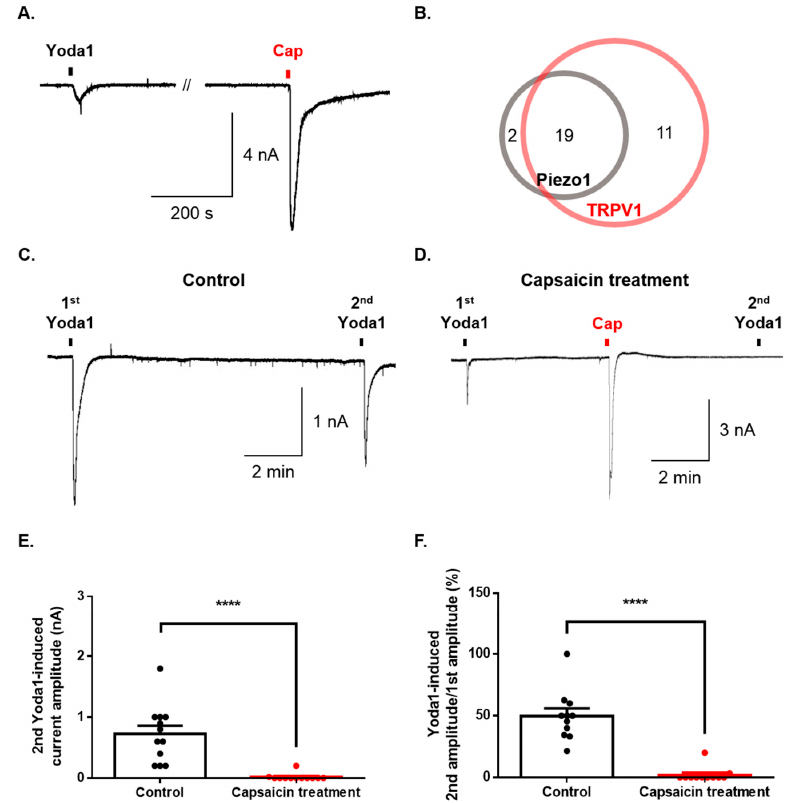
Figure 4. Regulation of Piezo1 by TRPV1 activation in the same dorsal root ganglion (DRG) neurons. ( A ) Representative trace of the inward current induced by Yoda1 (10 µ M, 10 s) and capsaicin (cap, 100 nM, 10 s) in the same neuron. ( B ) The number of neurons activated by Yoda1 or/and capsaicin. ( C ) A representative trace of the Yoda1 (10 μ M, 10 s)-induced inward current (control group). ( D ) A representative trace of the effect of the inward current of Piezo1 by capsaicin (cap, 100 nM, 10 s) (capsaicin treatment group). ( E ) The mean peak amplitude of the second application of Yoda1 (10 μ M, 10 s) after capsaicin treatment ( D ) or not ( C ) ( n = 12, unpaired t-test, ****, p < 0.0001). ( F ) The percentage of the second Yoda1-induced amplitude after capsaicin treatment (or not) compared to the first Yoda1-induced amplitude ( C ) and ( D ) ( n = 11, unpaired t-test, ****, p < 0.0001). The results are presented as the mean ± standard error of the mean (SEM).